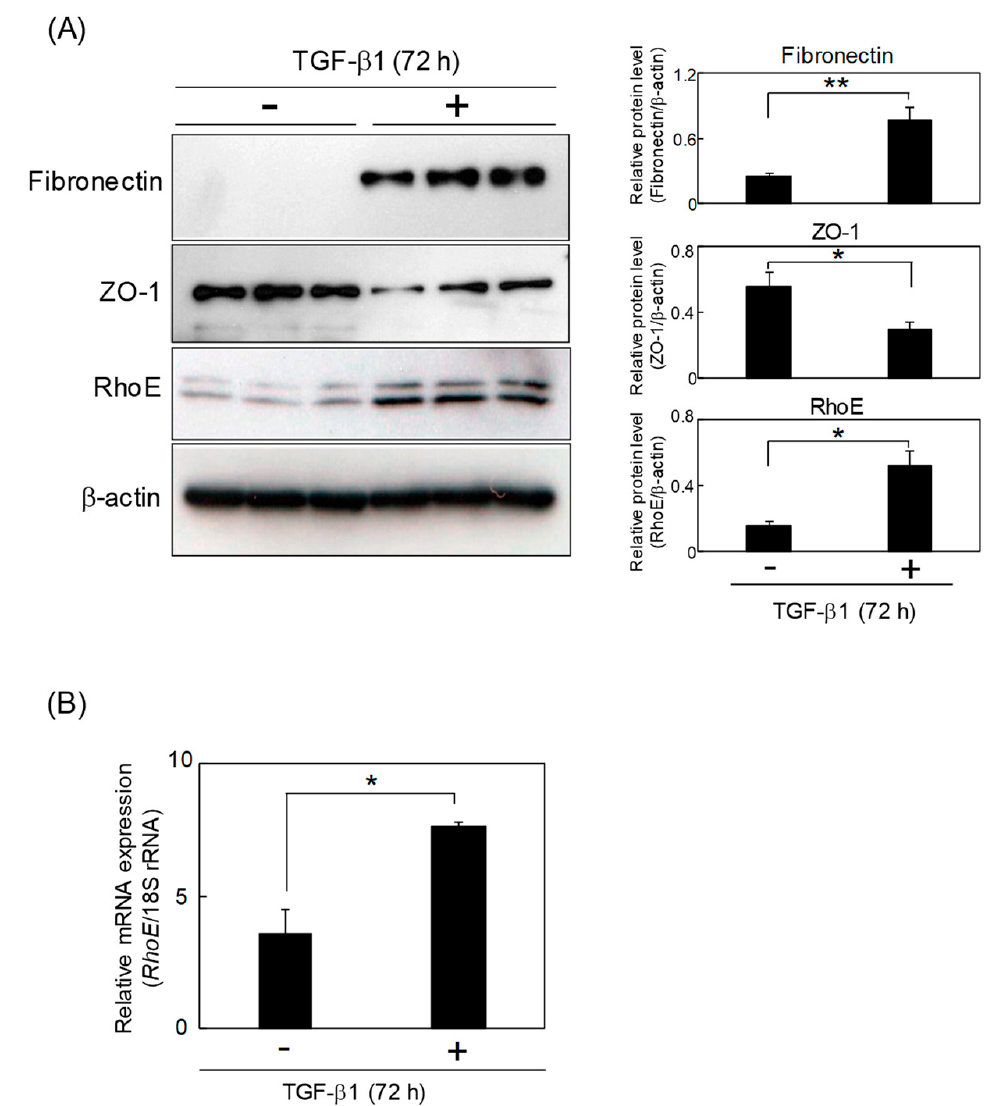
Figure 1. RhoE expression is elevated during transforming growth factor- β (TGF- β )-mediated epithelial-to-mesenchymal transition (EMT) in HeLa cells. ( A ) Protein levels of RhoE, fibronectin, and ZO-1 in HeLa cells after treatment with 1 ng / mL TGF- β 1. Whole-cell lysates were subjected to Western blot analysis and β -actin was used as a loading control. The three lanes represent triplicates using cell lysates prepared from di ff erent culture plates. Signal intensities of the proteins were quantified independent experiments. ( B ) qPCR analysis of RhoE expression in HeLa cells treated with TGF- β